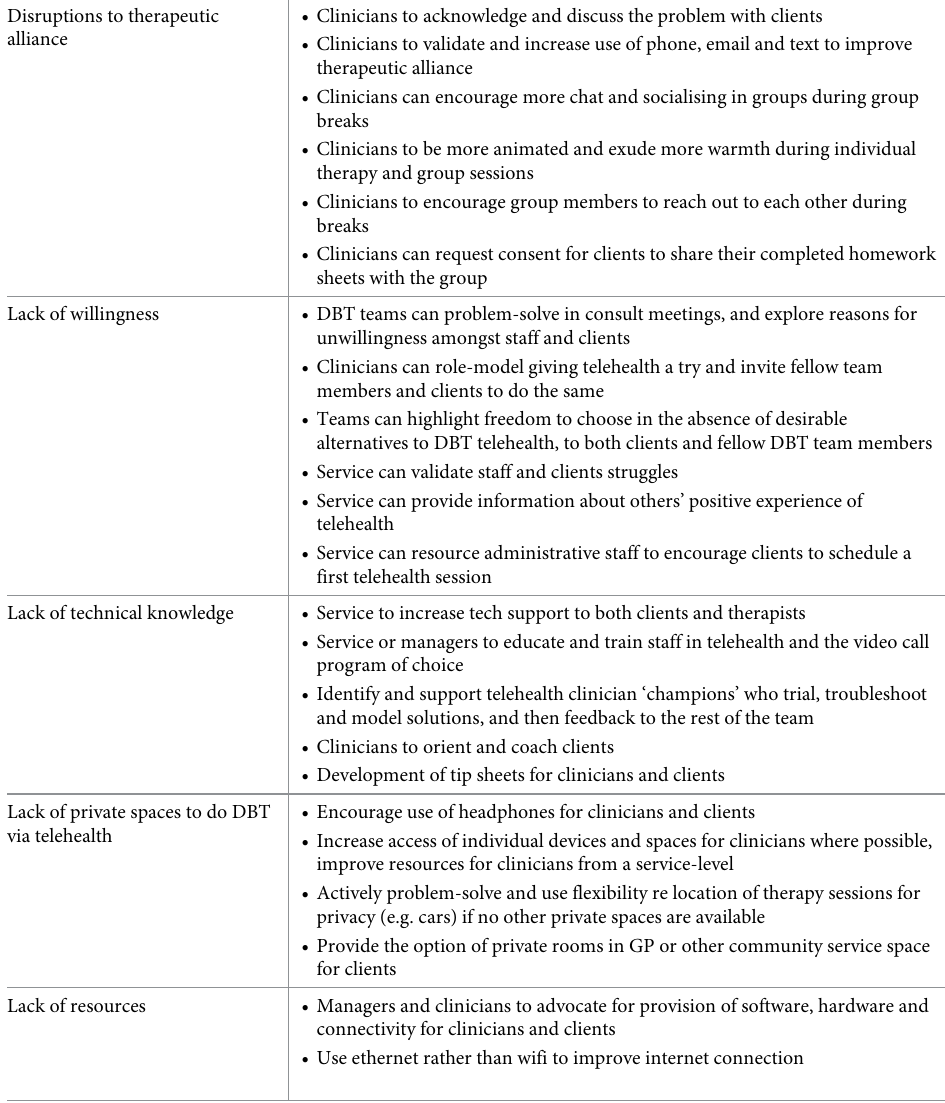
Table 3. Perceived barriers for both therapists and clients in delivering DBT via telehealth, and associated solutions. Disruptions to therapeutic